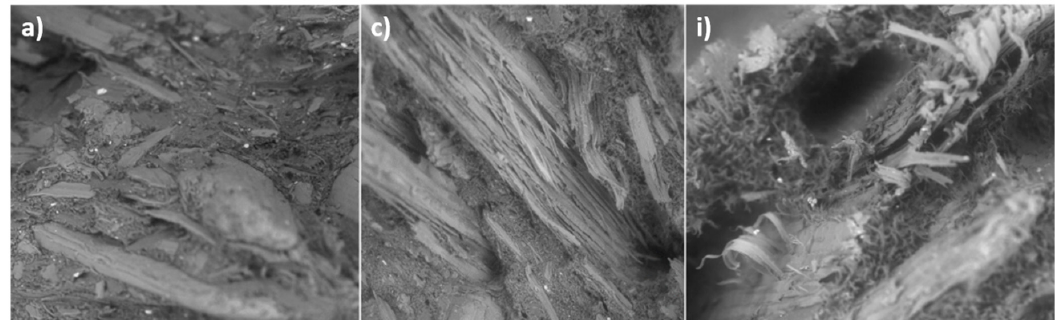
Figure 3. Enlarged details of a ): NC, c ): N525-7 and i ): MAM-7.